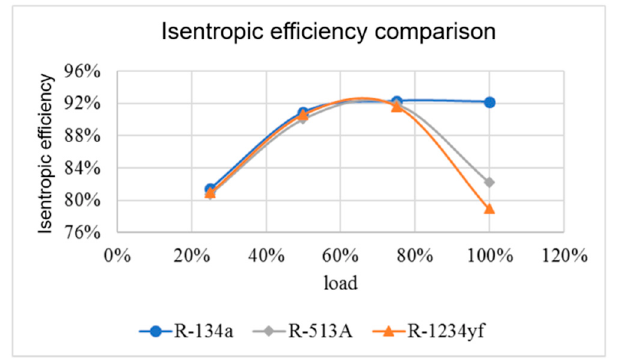
Figure 12. Comparison diagram of isentropic efficiency of refrigerants .